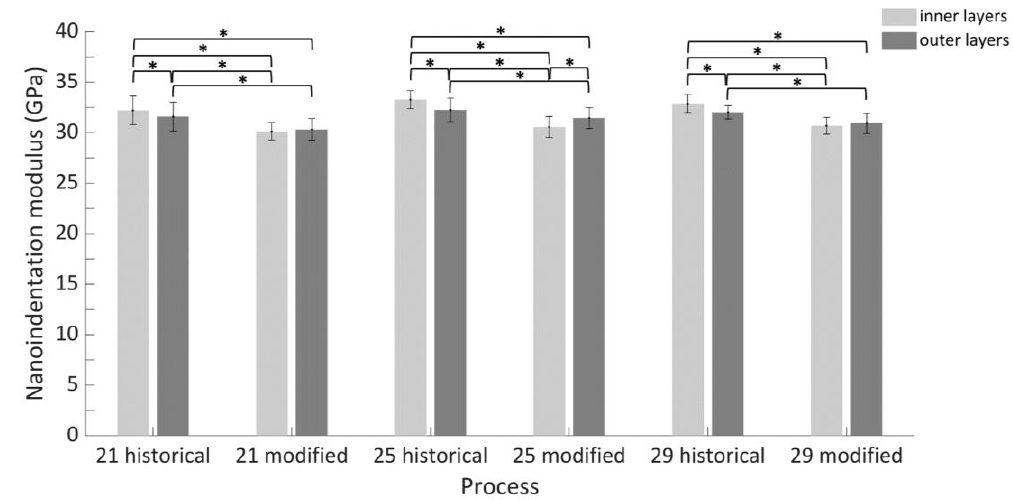
Figure 8. Mean values of nanoindentation modulus, for the inner layers and the outer layers. On the abscissa the diameter (mm) of the orifice and the deposition method. Where the * indicates significant differences between the mean values (p < 0.05).